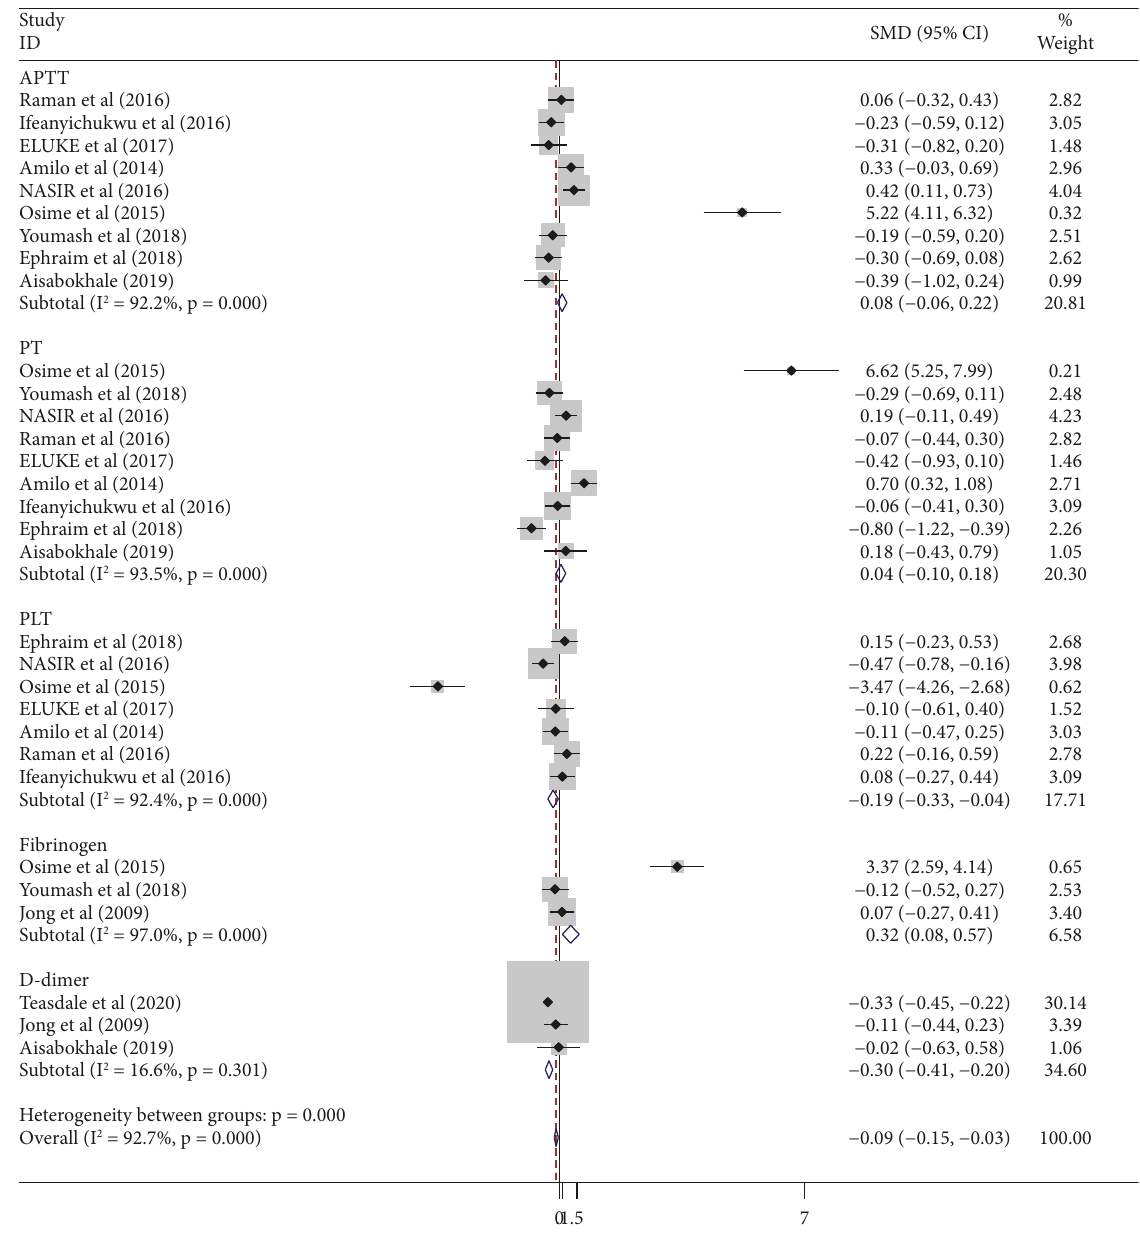
Figure 4: Forest plot showing comparison of coagulation parameters between HAART and HAART- na¨ıve HIV-infected patients.